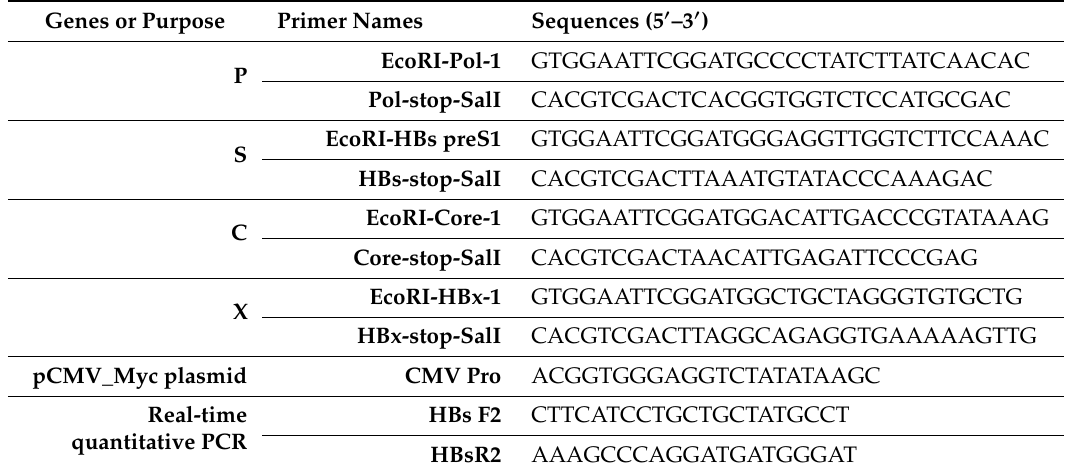
Table 1. List of primers used in this